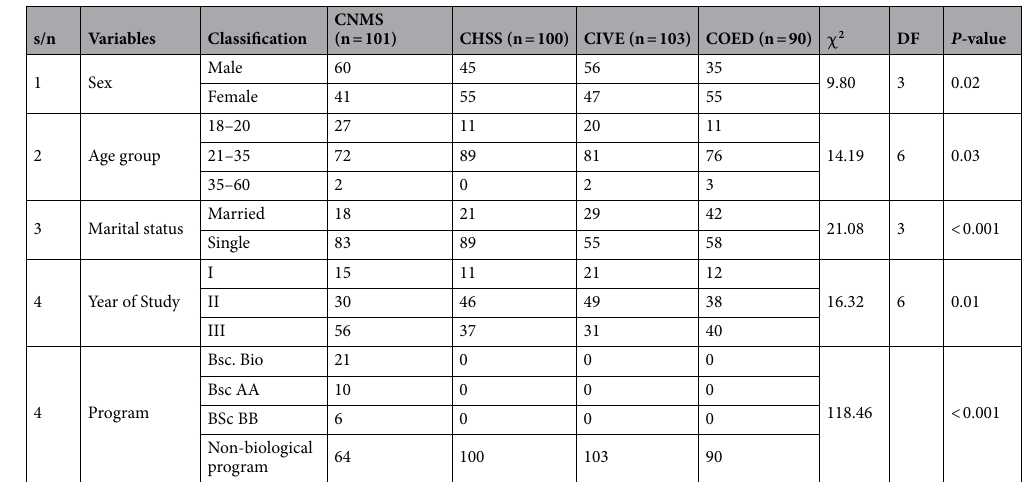
Table 2. Demographic structure of respondents across the four colleges. P-value , probability value; CNMS , college of natural and mathematical science; CHSS , college of humanities and social science; CIVE , college of informatics and virtual education; COED , college of education; χ 2 , Chi square; D.F ., degree of freedom.